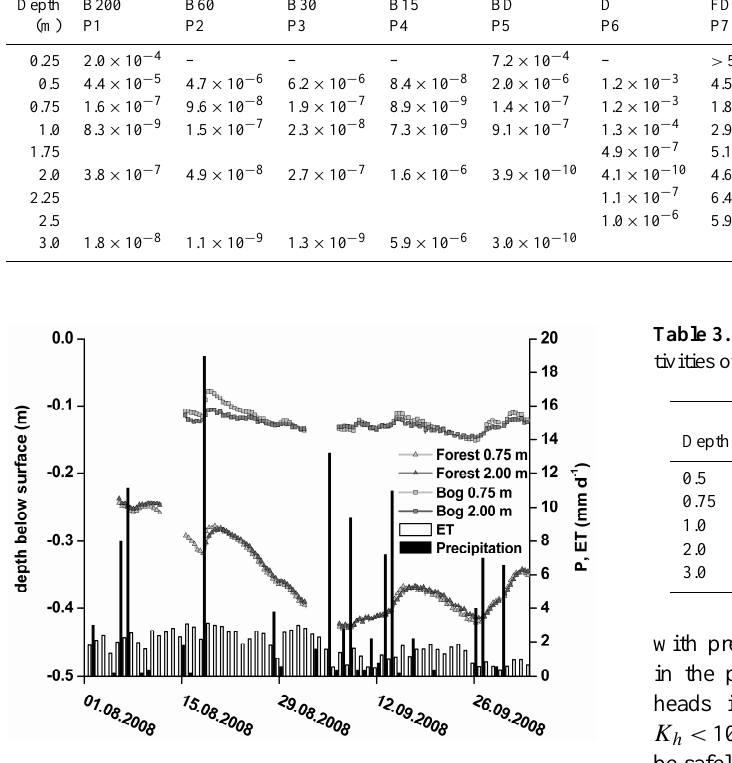
Fig. 3. Hydraulic potentials in 0.75 and 2.0m depth of the 200m sites at the Forest (light and dark grey triangles, Forest) and the bog (light and dark grey squares, Bog). P in mmd − 1 is displayed as black bars and ET in mmd − 1 as white bars.